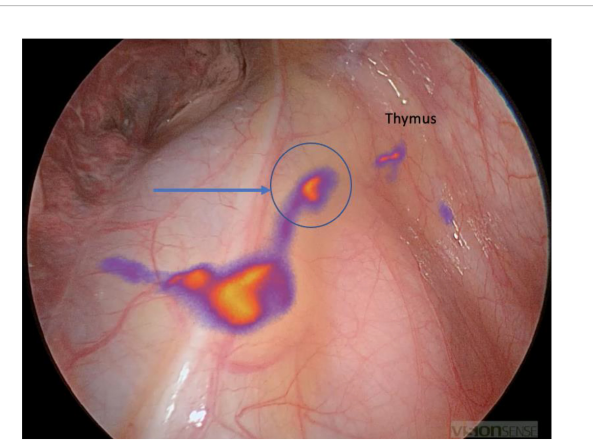
FIGURE 4 Atypical location of a sentinel lymph node in position 3A in the context of a right S6 segmentectomy: the path is seen in front of the superior vena cava and then a fi xation at the lymph node level in front of the right phrenic nerve (blue arrow). Note the fi xation of the thymus on the right upper part of the image.